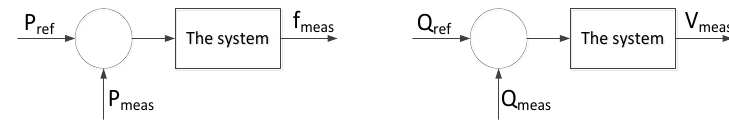
Figure 1. Open-loop frequency and AC-bus voltage control through the power control strategy.